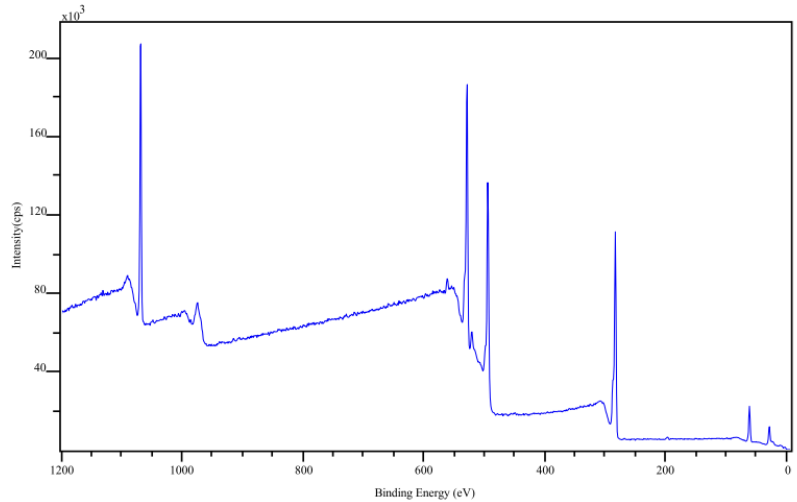
Figure 5. XPS survey scan for Na-Pery sample.